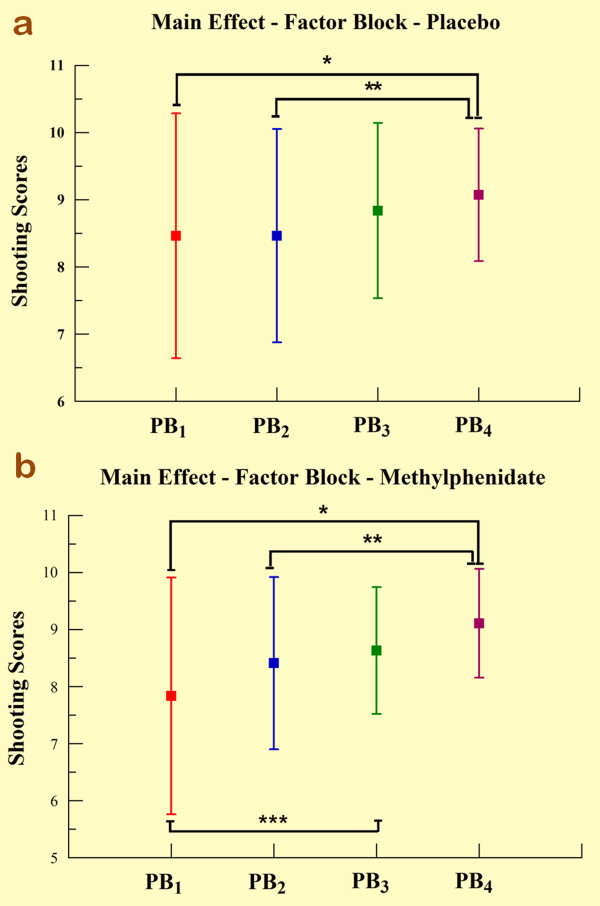
Comparison between placebo and methylphenidate main effects for factor block. (A) Main effect for factor block observed through mean and SD only into placebo. *Significant difference (Scheffé test; p < 0.05). **Significant difference (Scheffé test; p < 0.035). (B) Main effect for factor block observed through mean and SD only into methylphenidate. *Significant difference (Scheffé test; p < 0.003). **Significant difference (Scheffé test; p < 0.001). ***Significant difference (Scheffé test; p < 0.011).